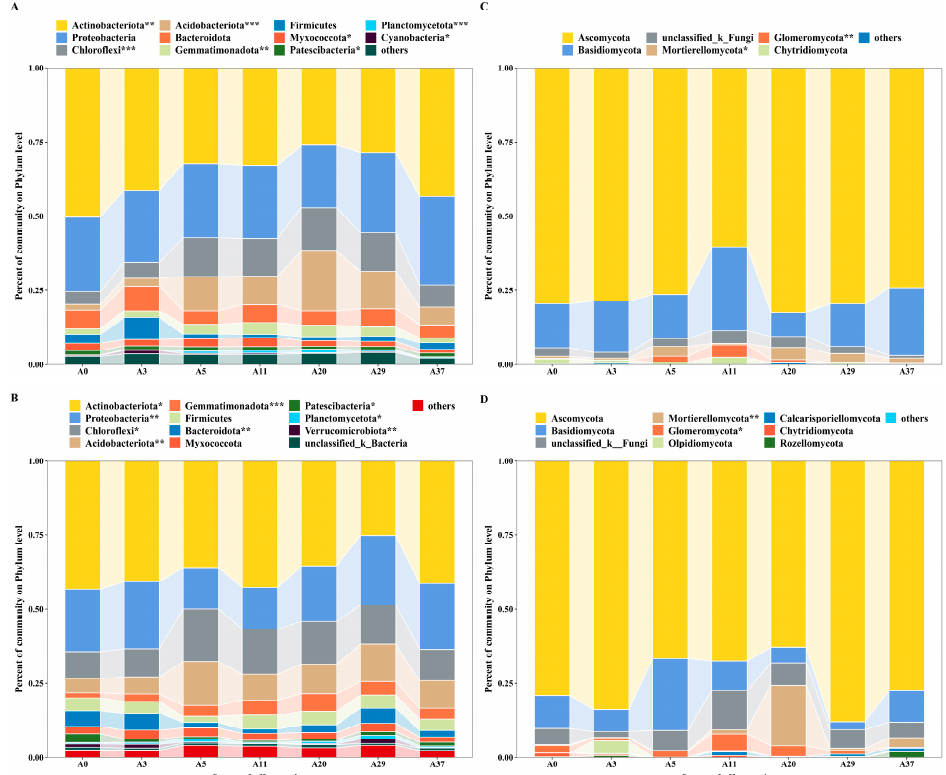
Figure 1. Community composition of bacteria ( A , 0–10 cm; B , 10–20 cm) and fungi ( C , 0–10 cm; D , 10–20 cm) at the phylum level for di ff erent stages of a ff orestation by aerial sowing in the northeast- ern Tengger Desert, China. The signi fi cance of the di ff erences between stages was tested by a Krus- kal–Wallis H test and represented as follows: * p < 0.05, ** p < 0.01, *** p < 0.001.